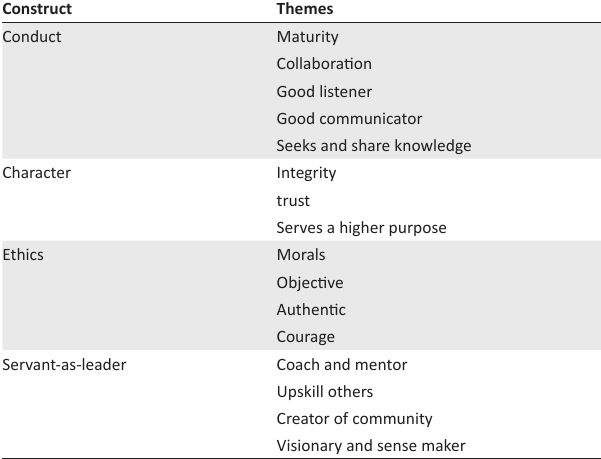
TABLE 2: Major themes explored.